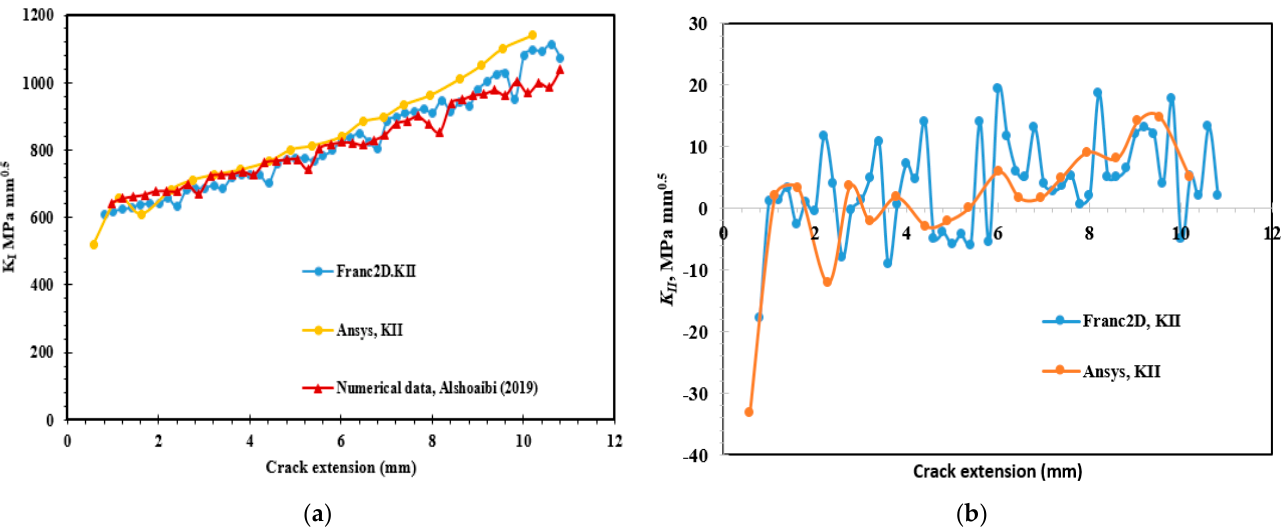
Figure 11. Stress intensity factors with corresponding crack length for specimen G4, ( a ) K I , and ( b ) K II .